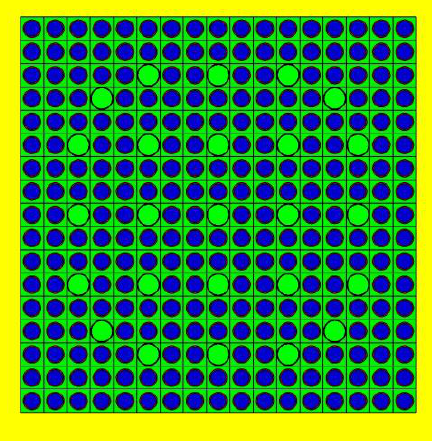
Figure 1. Generic water-moderated 17x17-25 PWR fuel assembly reflected by